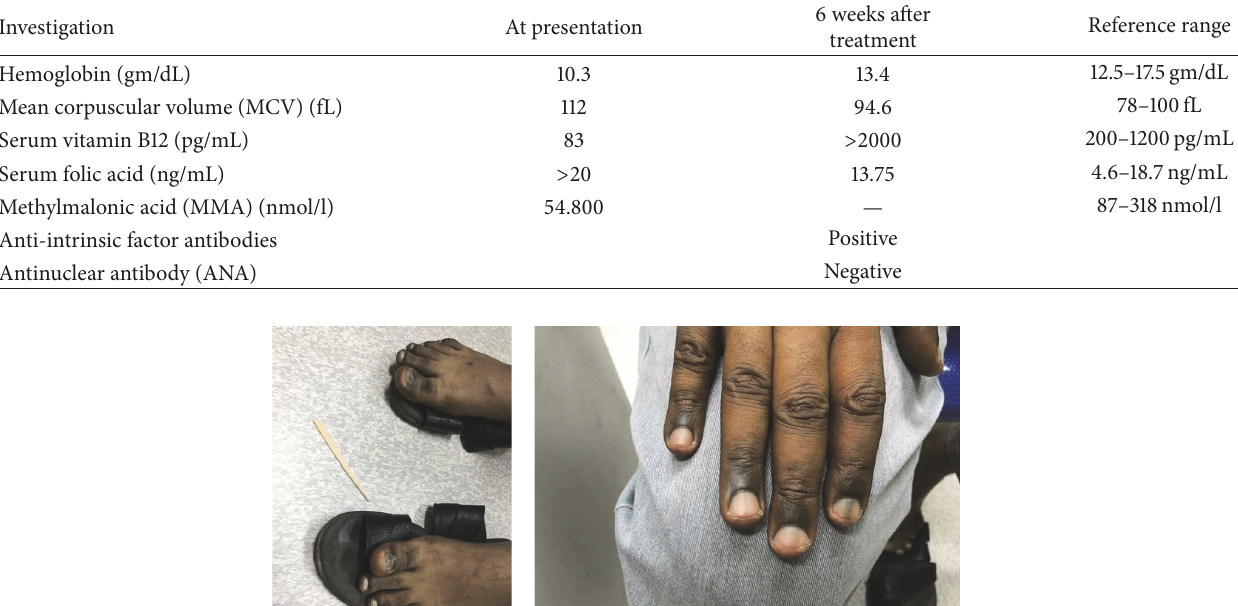
Table 1: Laboratory findings.